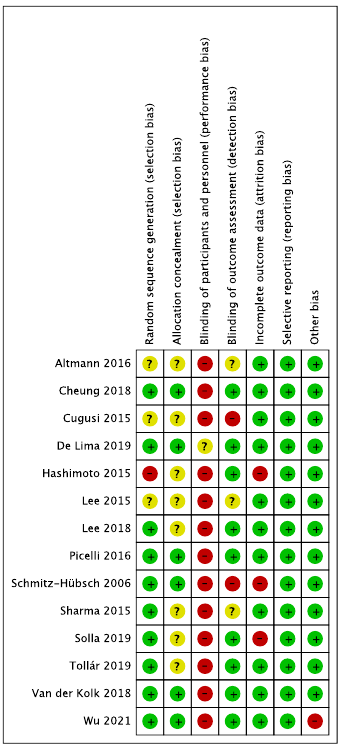
Figure 2. Methodological quality of included studies [24,25,30 – 41].